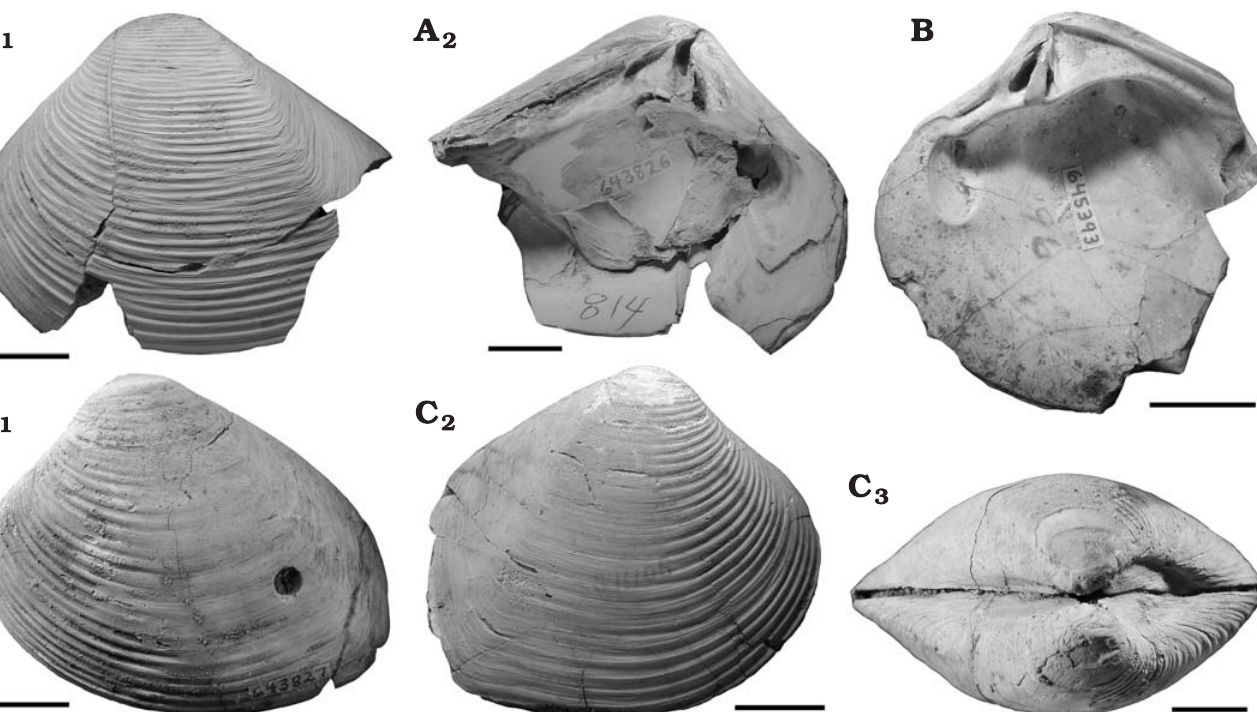
Fig. 5. Crassatellid veneriform bivalves Hybolophus species from the late Miocene of Ecuador and Colombia. A , B . Hybolophus picaderus (Olsson, 1964), Ecuador. A . USNM 643826, holotype, Picaderos Formation, Picaderos; exterior (A 1 ) and interior (A 2 ) of left valve. B . USNM 645393, paratype, Mompiche-Portete; interior of right valve. C . Hybolophus tuberus (Olsson, 1964), USNM 643827, holotype, Tubera Formation, Tubera-Puerto Caiman, Colombia; exterior of left (C 1 ) and right (C 2 ) valves, dorsal margin of paired valves (C 3 ), anterior at right. Scale bars 10